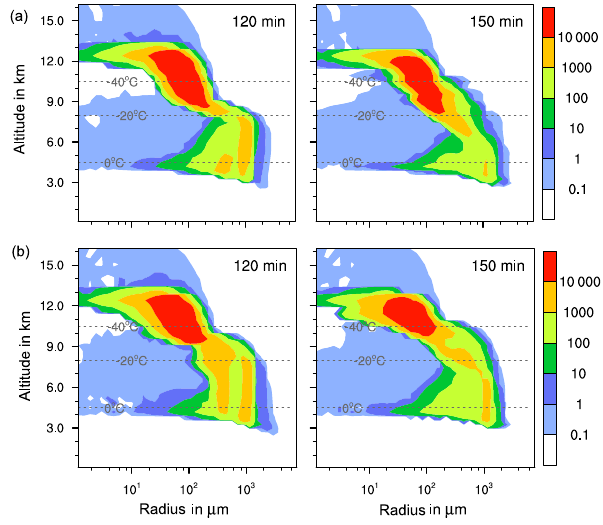
Figure 12. Ice particle size spectra in the center cell of the cloud after 120 and 150min for cases with 1% kaolinite–Saharan dust. Number concentrations per m 3 . (a) Solely immersion freezing and (b) combined immersion, deposition, and contact